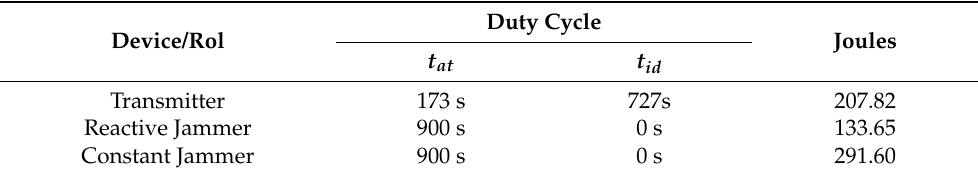
Table 6. Energy consumption for each device and role in the experiments are tabulated. The trans- mitter only considers the jammer scenario to compare the results.